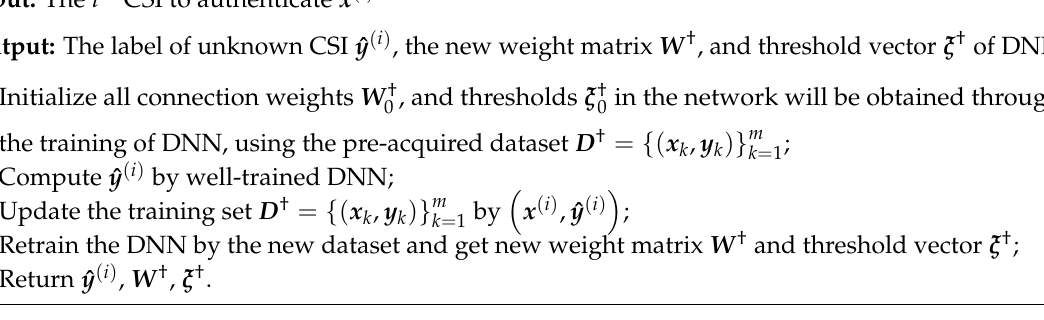
Algorithm 1 DNN-based sensor nodes’ authentication.